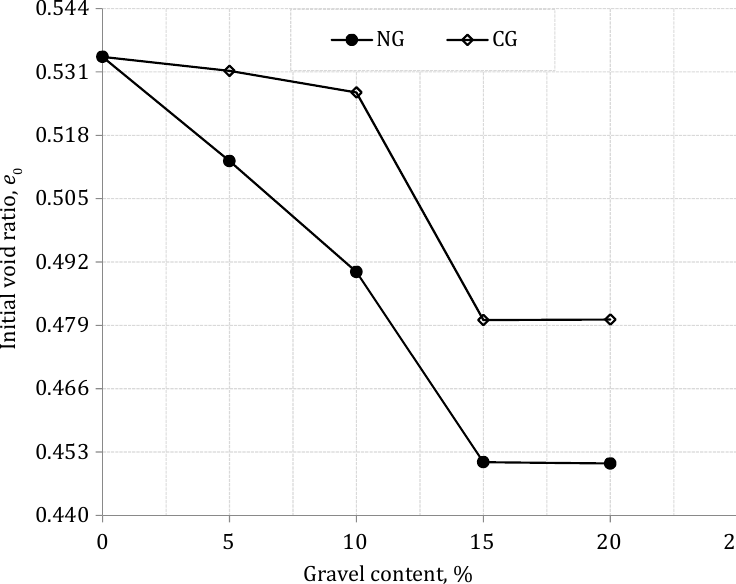
Figure 10. Variation of e 0 in the clay with NG and CG